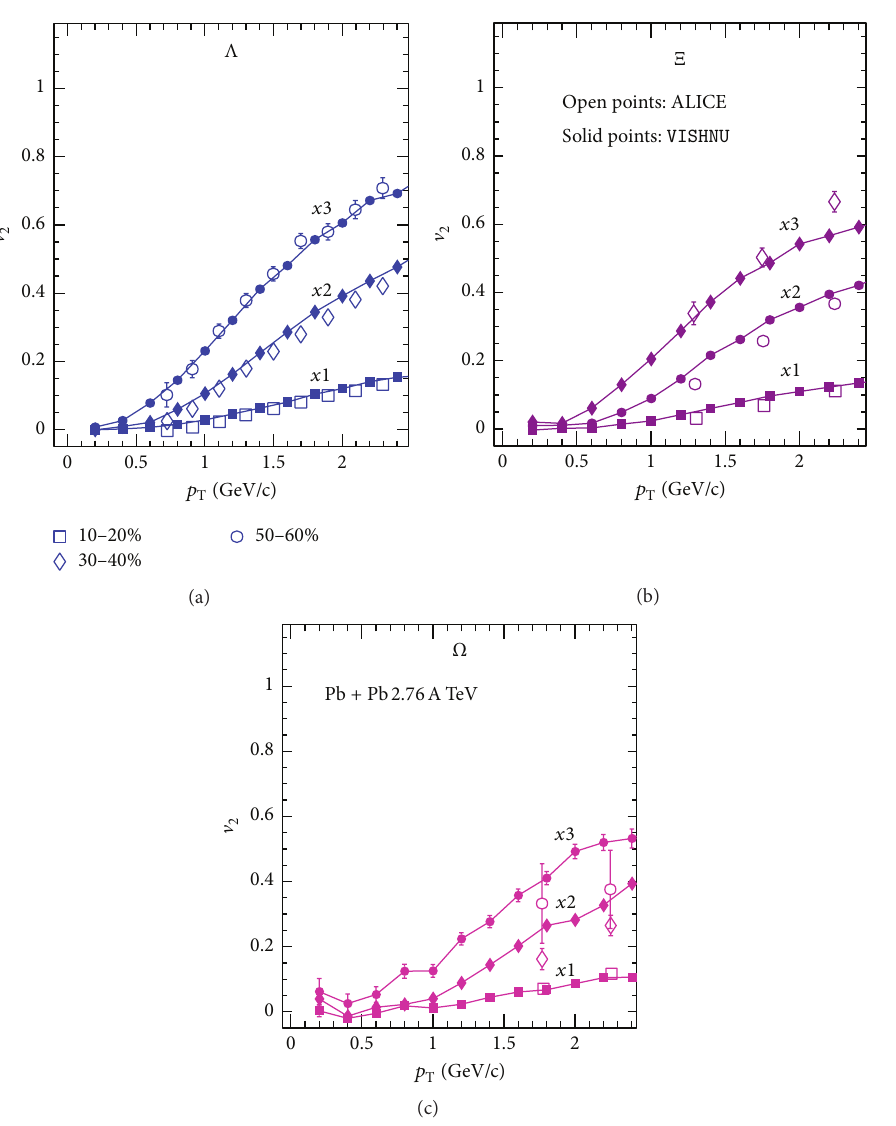
Figure 4: Differential elliptic flow of strange hadrons Λ (a), multistrange hadrons Ξ (b) and Ω (c) at 10–20% (squares), 30–40% (diamonds), and 50–60% (circles) centralities in Pb + Pb collisions at √𝑠 NN = 2.76 TeV. Experimental data (open points) are from the ALICE measurements [23]. Theoretical results (solid points) are calculated from the VISHNU hybrid model with the inputs presented in Section 2, which were first shown in